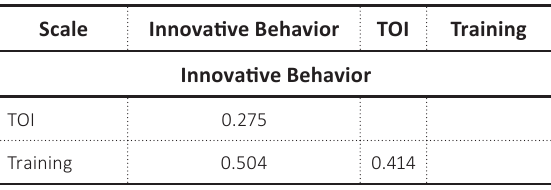
Table 3. Discriminant validity based on HTMT0